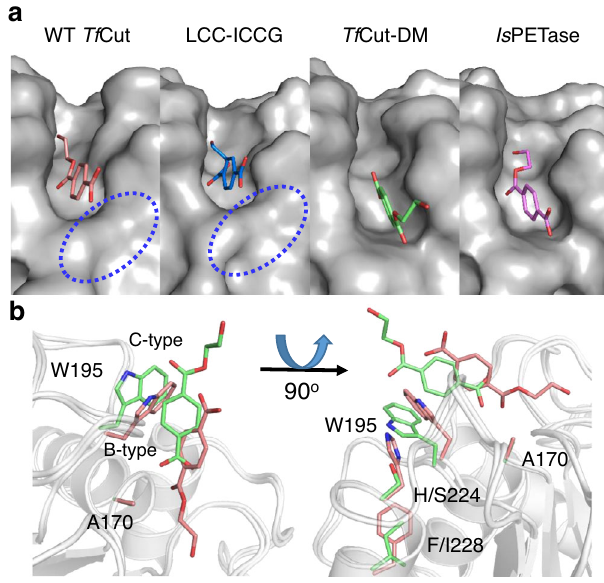
Fig.4|ComparisonofbindingposesofMHETinWT Tf Cutand Tf Cut-DM.a The superimposed active site clefts of MHET-bound complex of WT Tf Cut (PDB ID, 7XTV), LCC-ICCG (PDB ID: 7VVE), Tf Cut-DM (PDB ID, 7XTT), and Is PETase (PDB ID: 7XTW). The MHET-binding pockets are displayed with surface representation, and the dashed circles highlight the location of H224 and F228. b Comparison of binding modes of MHET in WT Tf Cut (red) and Tf Cut-DM (green). The selected residues are shown as